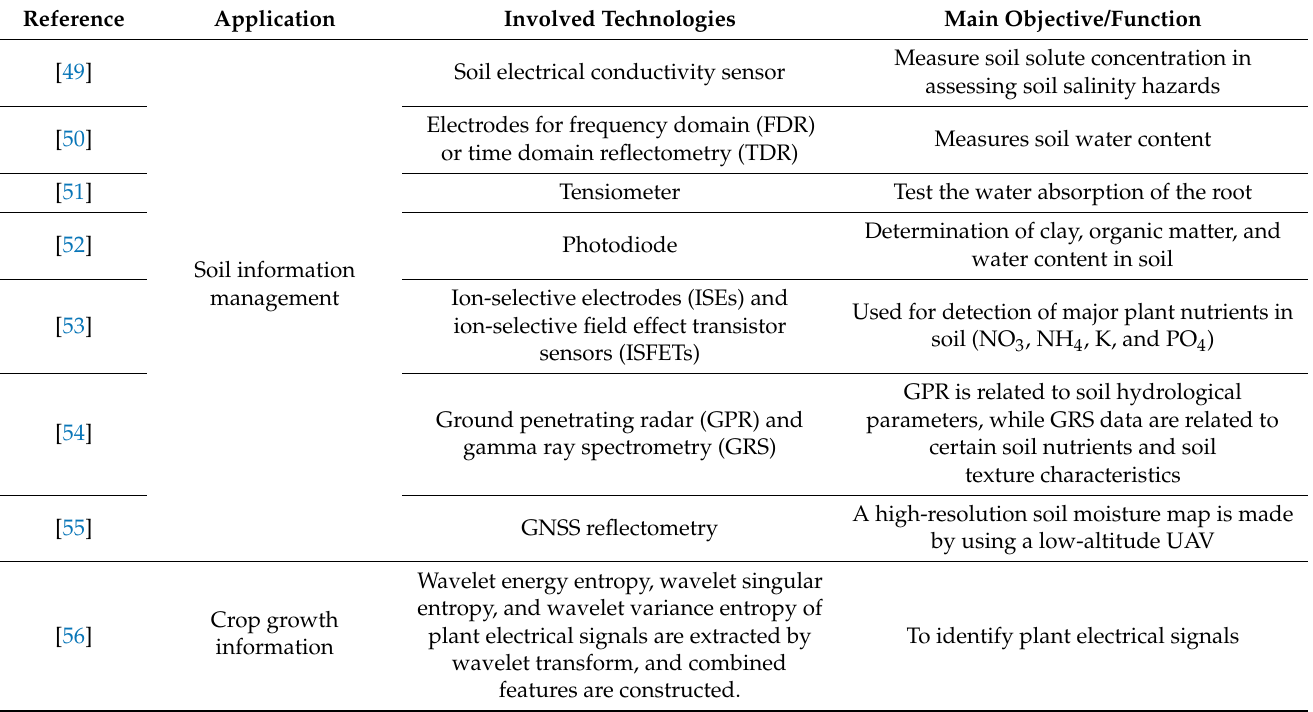
Table 2. Field information collection